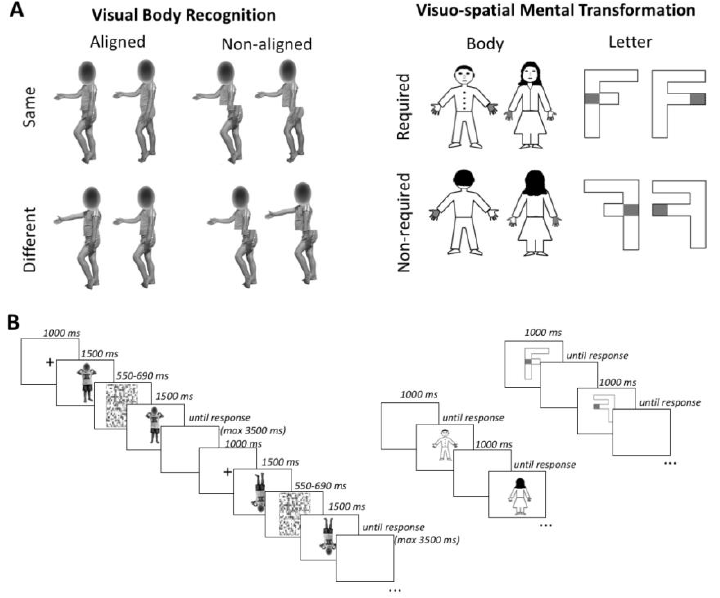
Figure 1. Experimental Paradigms. ( A )—Illustration of stimuli of the Visual Body Recognition Paradigm ( left side ) and the Visuo-spatial Imagery Paradigm ( right side ). ( B )—Schematic represen- tation of the time line of the trials.